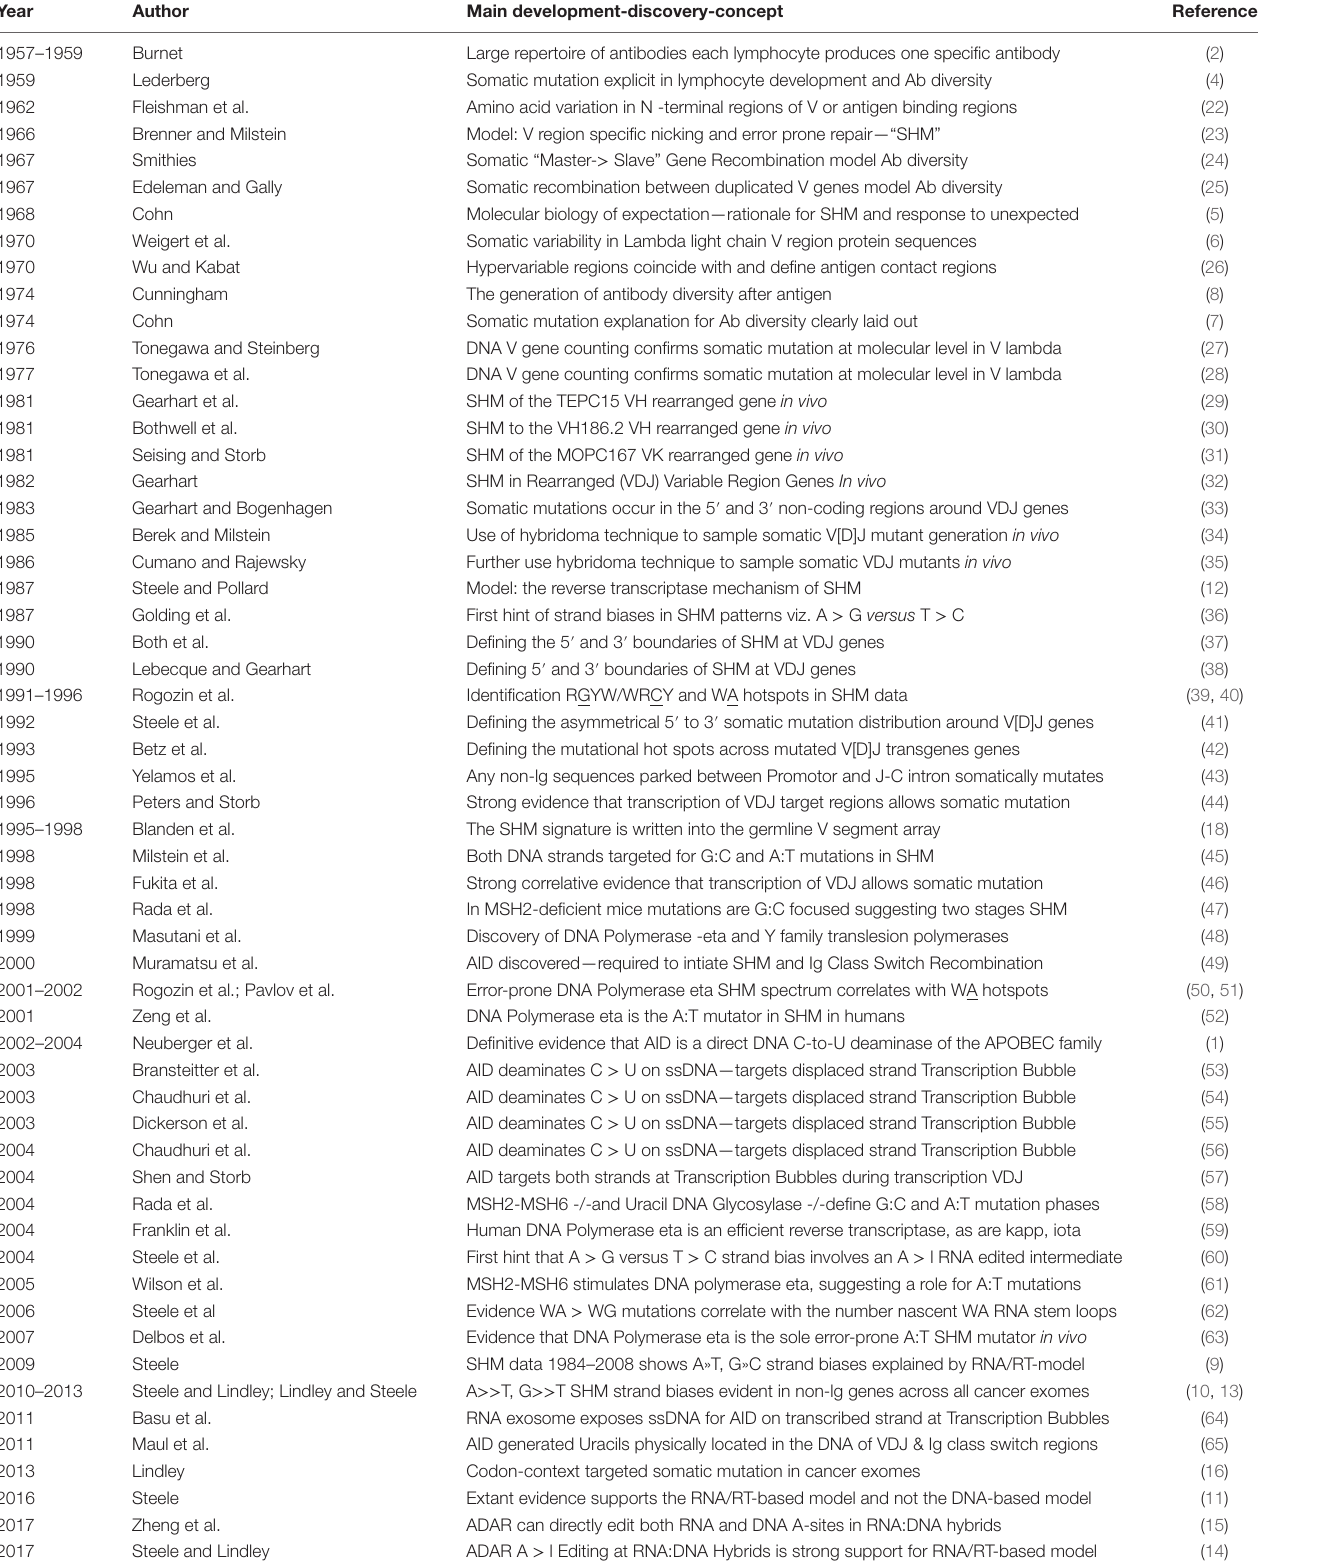
tABLe 1 | History of somatic hypermutation (SHM): developments relevant to the reverse transcriptase